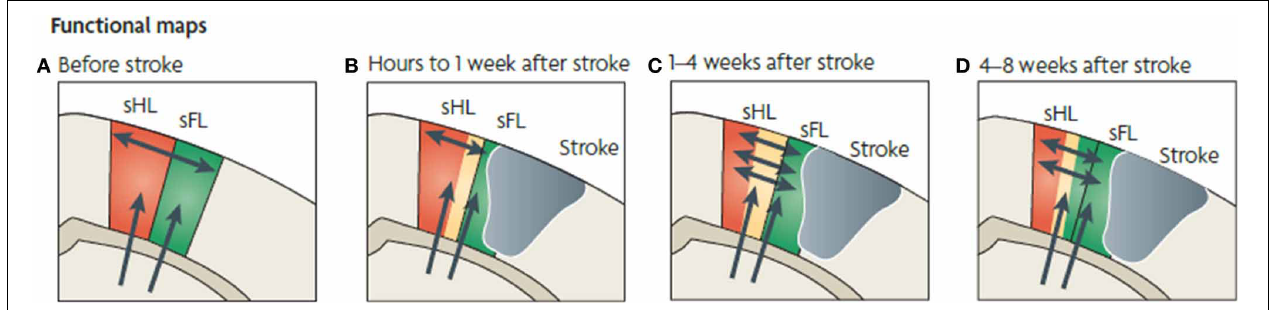
FIGURE 5 | Functional map changes in forelimb (sFL) and hindlimb (sHL) somatosensory cortex after a focal infarct in mouse. Thalamic projections (arrows) and intracortical connections (double arrows) are also shown. (A) Normal somatosensory representation of sFL and sHL. (B) Within hours after focal infarct (gray), yellow areas show reduced sensory specificity, responding to both FL and HL stimulation. (C) Over the ensuing weeks,